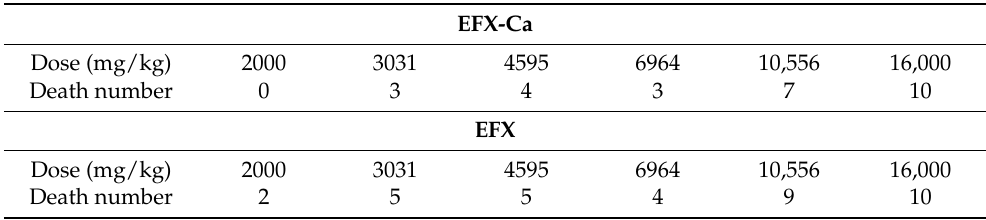
10,556 and 16,000 mg/kg) of EFX-Ca, compared with EFX.